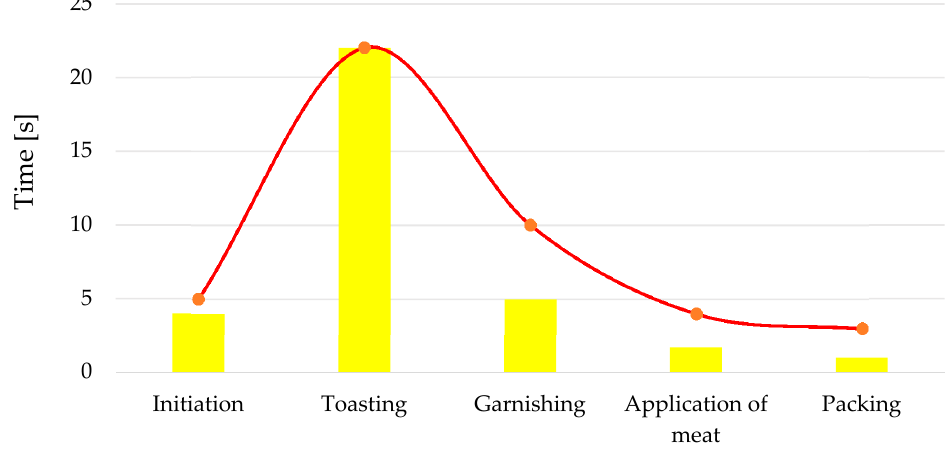
Figure 9. Histogram of times at work stations.